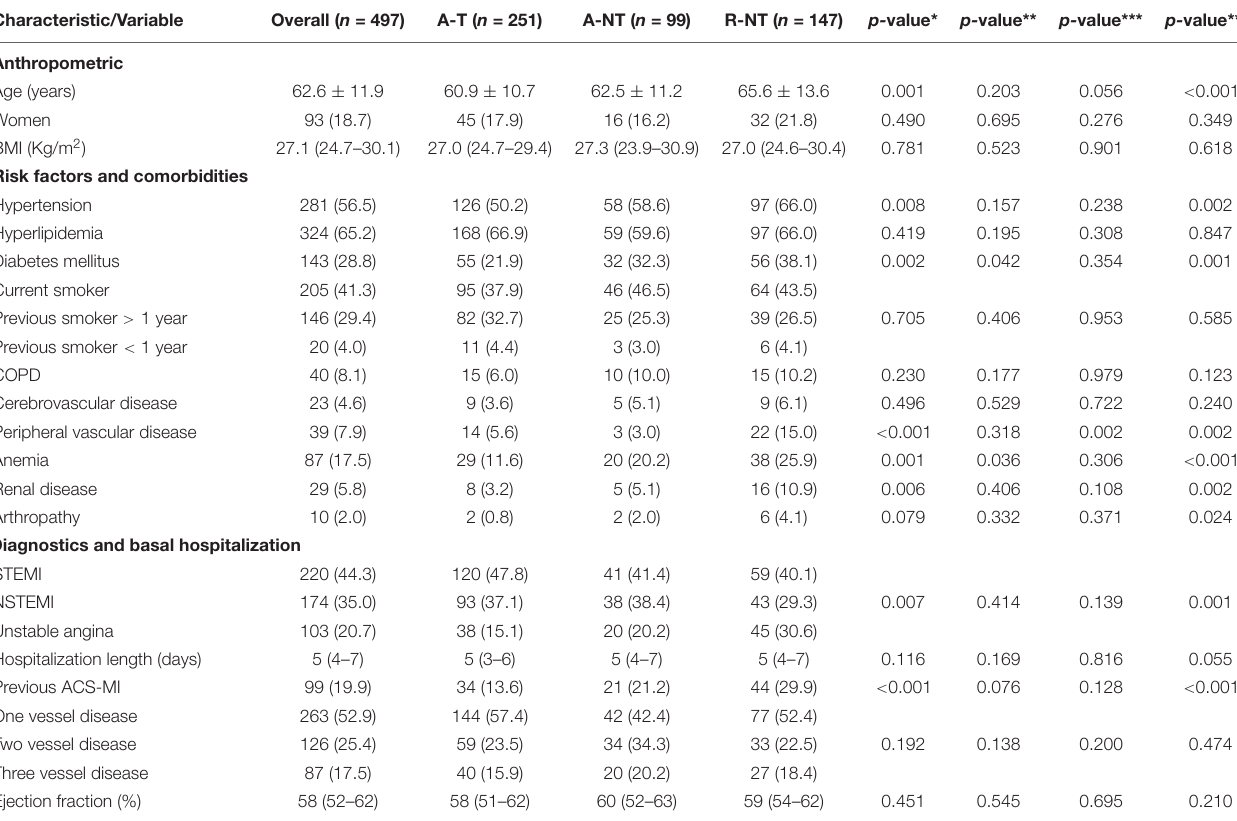
TABLE 1 | Baseline characteristics of patients in the cardiac rehabilitation program and in the three groups. Characteristic/Variable Overall ( n =